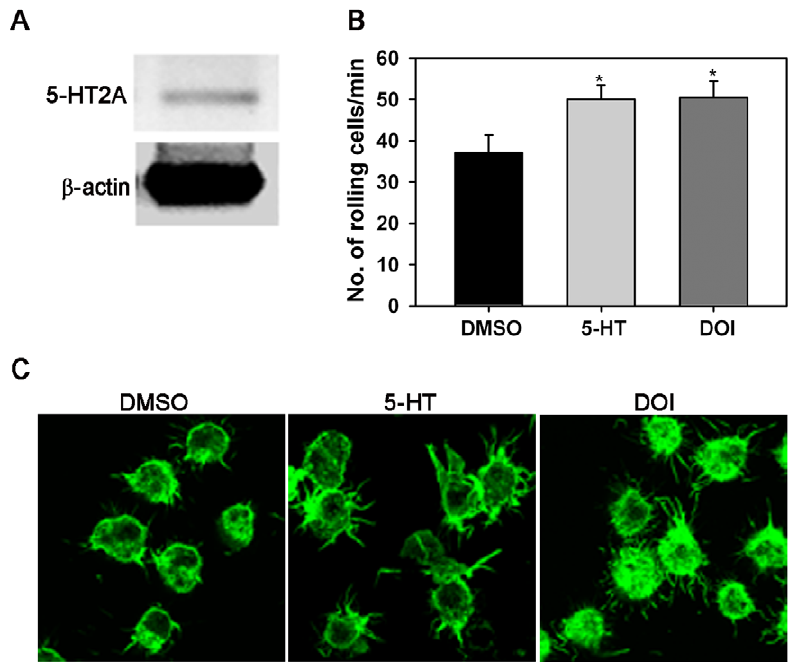
Figure 2. 5-HT and DOI induce rolling of AML14.3D10 human Eos-like cells. ( A ) Expression of 5-HT2A by AML14.3D10 cells by RT-PCR with b -actin as the internal control. ( B ) Rolling of AML14.3D10 cells on rh VCAM-1-coated cover-slips under conditions of flow in vitro after treatment with 5-HT, DOI or DMSO (vehicle) for 5 min prior to infusion into flow chamber. ( C ) Confocal microscopy of FITC-phalloidin stained AML14.3D10 cells adhered to rh VCAM-1 on cover-slips in the presence of vehicle (DMSO), 5-HT or DOI as described in Figure 1. Magnification 6 600. Combined data (Mean 6 SEM) of 3 (for 5-HT)-5 (for DOI) independent experiments in duplicate is shown for B. *p , 0.03 in B for comparison of 5-HT- or DOI-treated versus vehicle-treated cells. Data shown in C is representative of three independent experiments.